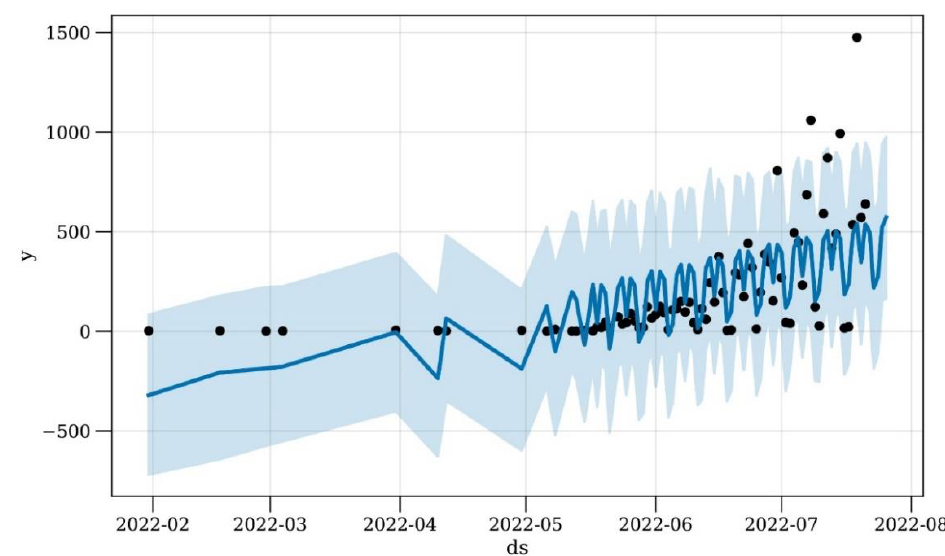
Figure 23. Confirmed cases of Prophet model prediction. Where ‘y’ represents the measurement of forecast and ‘ds’ represents date stamps. The original data are represented by black dots on the blue line, while the forecast error is shown by the shaded blue area.